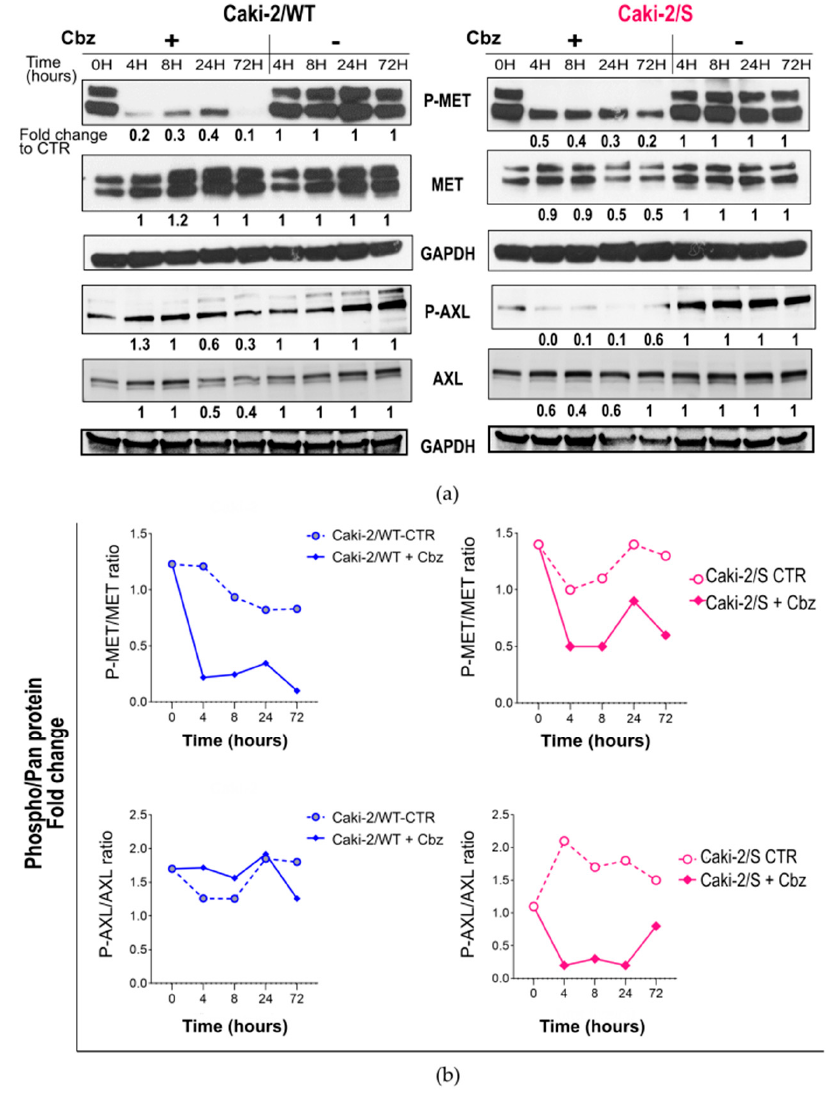
Figure 4. Effect of cabozantinib on signal transduction in human RCC treatment-naïve Caki-2/WT cells and following long-term treatment with sunitinib Caki-2/S cell lines. ( a ) Cell lysates (20 µ g) obtained from Caki-2/WT and Caki-2/S cells treated (+) with 12 µ M of cabozantinib (Cbz) or untreated ( − ) with DMSO 0.1% at four time points were analyzed with an immunoblotting assay for specific antibodies with phosphorylated and total MET and AXL receptor proteins. GAPDH expression was selected as the loading control of samples for indicated proteins. The optical density (OD) of the area of each band was quantified with ImageJ 1.52a software and normalized to that of GAPDH. Numbers below each line represent the fold changes of the target proteins, which were obtained by dividing the normalized expression from each lane by the normalized expression of the relative untreated controls (set as 1). ( b ) Kinetics of MET (Y1234/5) and AXL (Y779) following treatment with cabozantinib (+Cbz) and in the untreated control (CTR) at indicated time points. Phosphorylation kinesis adjusted for total MET (P-MET/tot MET) and total AXL (P-AXL/tot AXL). Representative immunoblotting image and relative quantification. Full-length blots of independent duplicates are presented in Supplementary Figures S2, S9 and S10. The figure was generated with Inkscape (version 1.0.2, RRID: